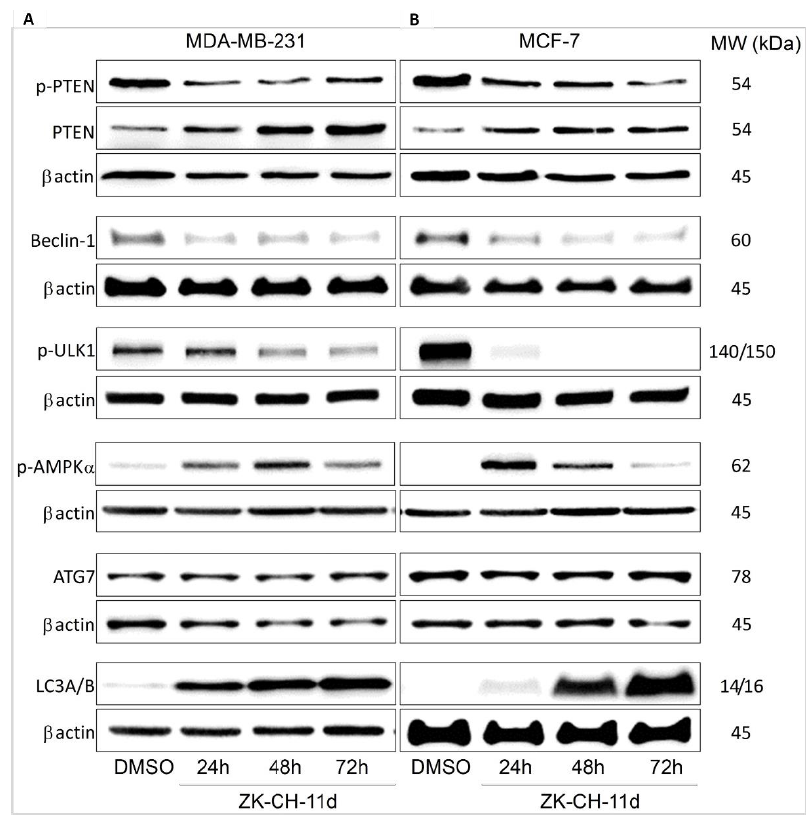
Figure 16. Western blot analysis of autophagy and autophagy-related proteins in MDA-MB-231 ( A ) and MCF-7 ( B ) cells after treatment with chalcone ZK-CH-11d for 24, 48, and 72 h of treatment.